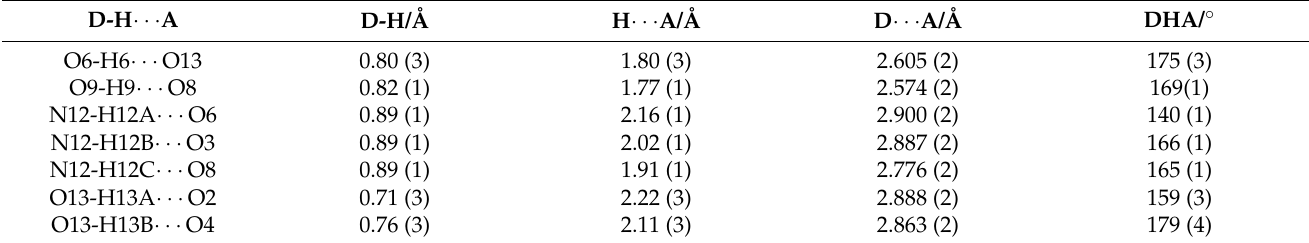
Figure 2. A fragment of the structure of (H 2 DAB)[Co(H 2 PO 3 ) 4 ]·2H 2 O along [010], showing the infi- nite four-membered ring chain propagating along [100]. Polyhedrons: cyan [CoO 6 ], yellow H 2 PO 3- .